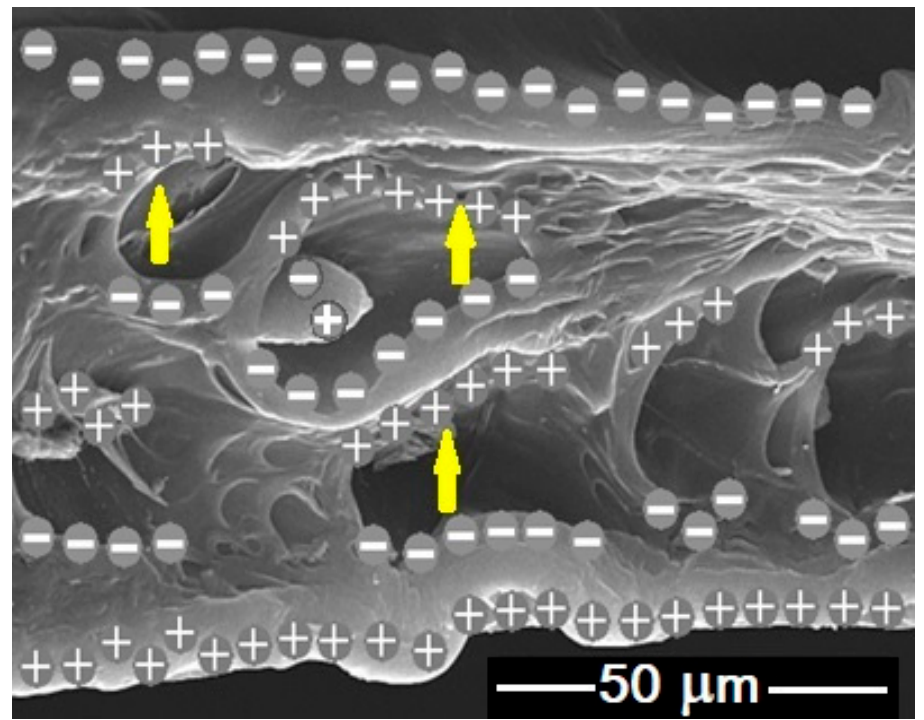
Figure 6. Schematic presentation of electrets in the cellular polyolefin composite based on an SEM image of the sample cross-section (yellow arrows show examples of dipole moment vectors occurring in the cavities).